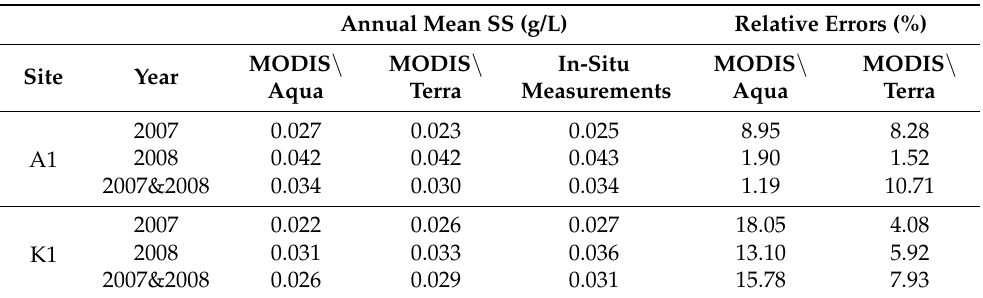
Table 6. Relative errors (RE, %) of annual mean SS from valid MODIS observations compared with in situ